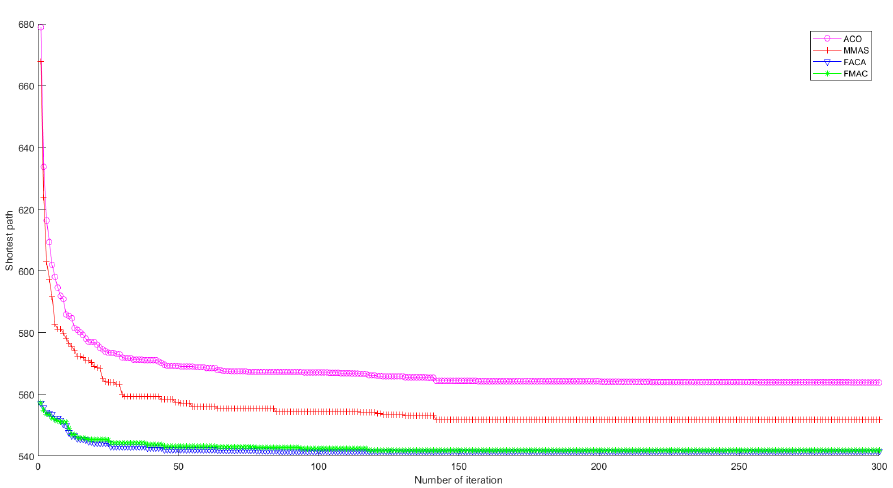
Figure 9. Average shortest path curve after each iteration in eil76.